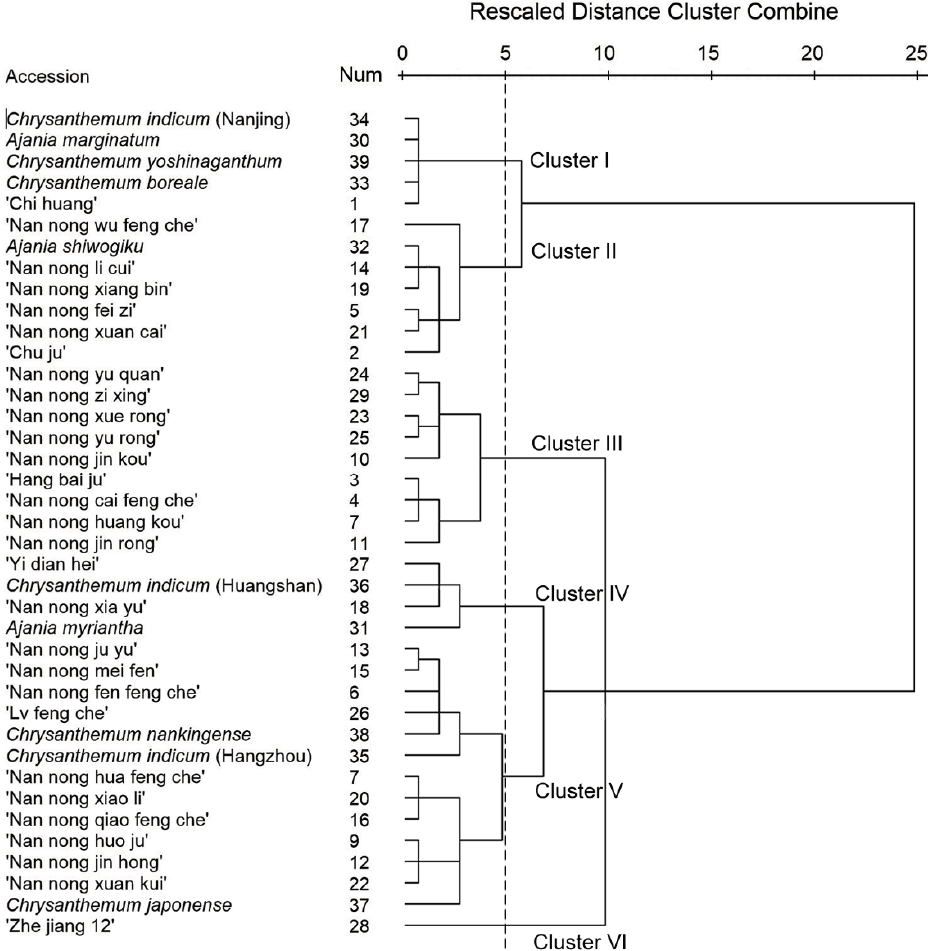
Figure 4. Hierarchical cluster dendrogram of 39 plant